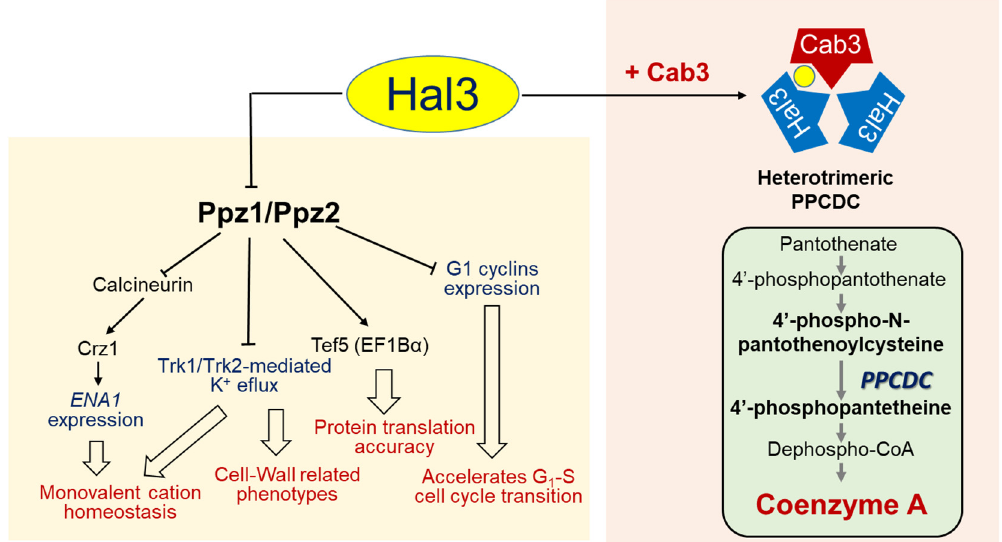
Figure 3. Cartoon depicting Ppz-dependent and independent functions of Hal3 in S. cerevisiae . See main text for details. The yellow circle on the right denotes the sole catalytic PPCDC site formed in the heteromeric PPCDC enzyme.